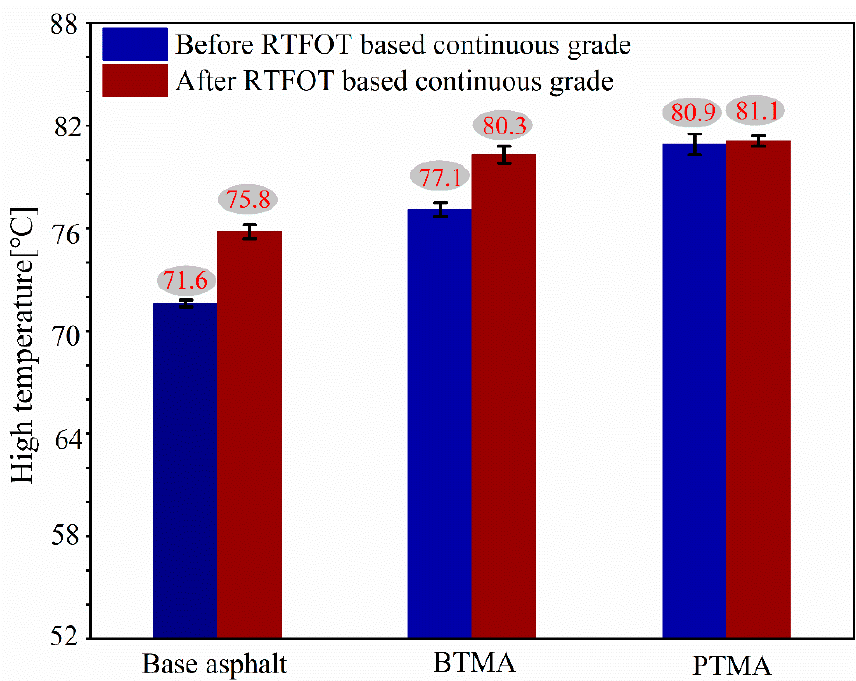
Figure 10. Continuous grading high temperature for all binders.